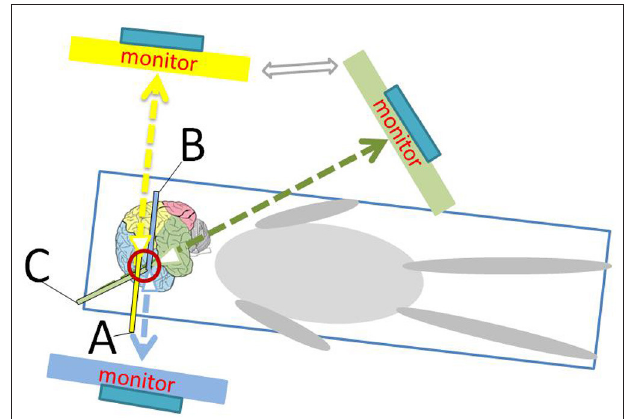
FIGURE 7 | Schematic diagram shows the position of the monitor and the operator during endoscopic surgery. (A) represents the head of the neuroendoscope facing the parietal and occipital directions; (B) represents the head of the neuroendoscope facing the frontal direction; and (C) represents the head of the neuroendoscope facing the temporal